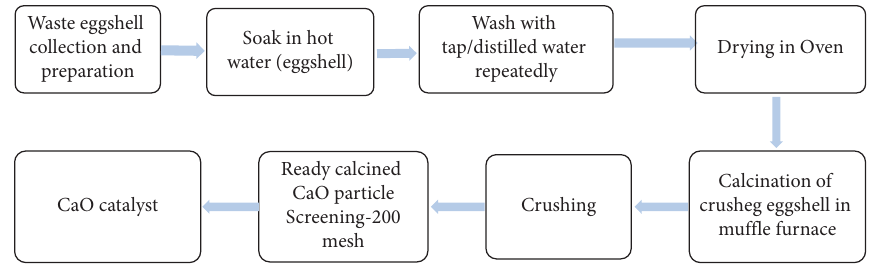
Figure 4: Block diagram showing the preparation of catalyst CaO-eggshell waste-derived process (own fgure). Table 1: Experimental work design for four